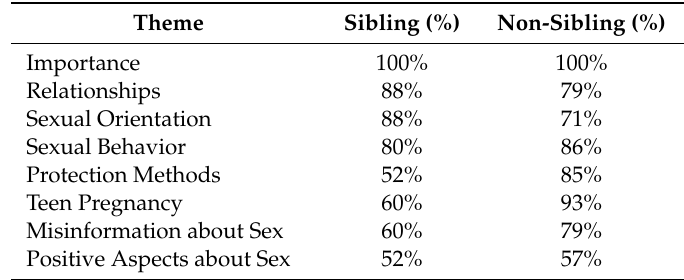
Table 2. Identified themes for sibling ( N = 25) and non-sibling ( N = 14)